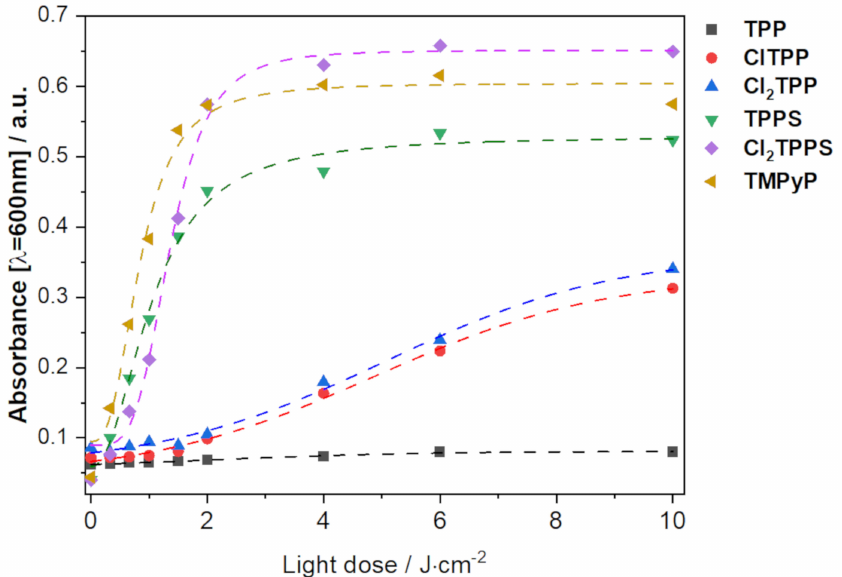
Figure 8. The absorbance of aliquots of photosensitizers (PSs) with 100 mM KI after irradiation with a 420 nm LED with various light doses and added to a starch indicator reagent.